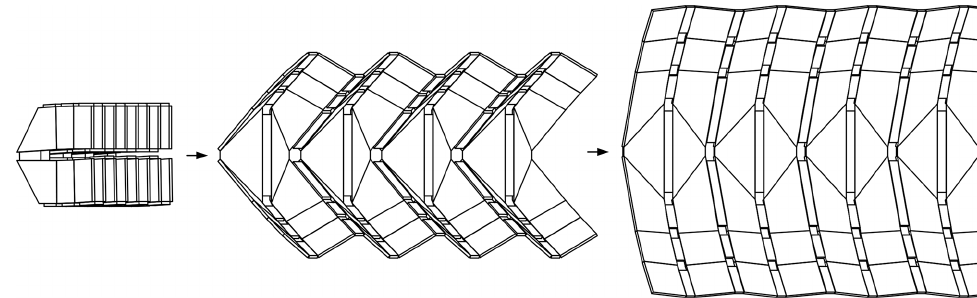
Figure 9. The cylindrical DM and its deployment